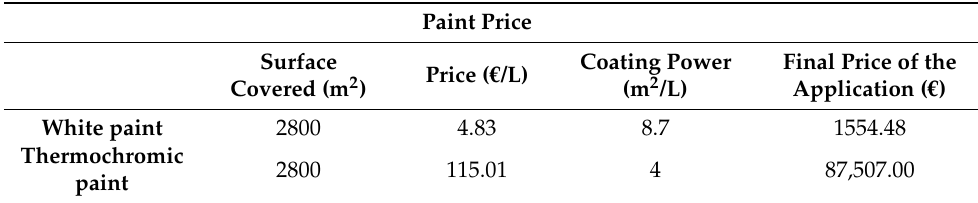
Table 8. Price of thermochromic and white paint application. Source: Prices consulted with Amazon (18 July